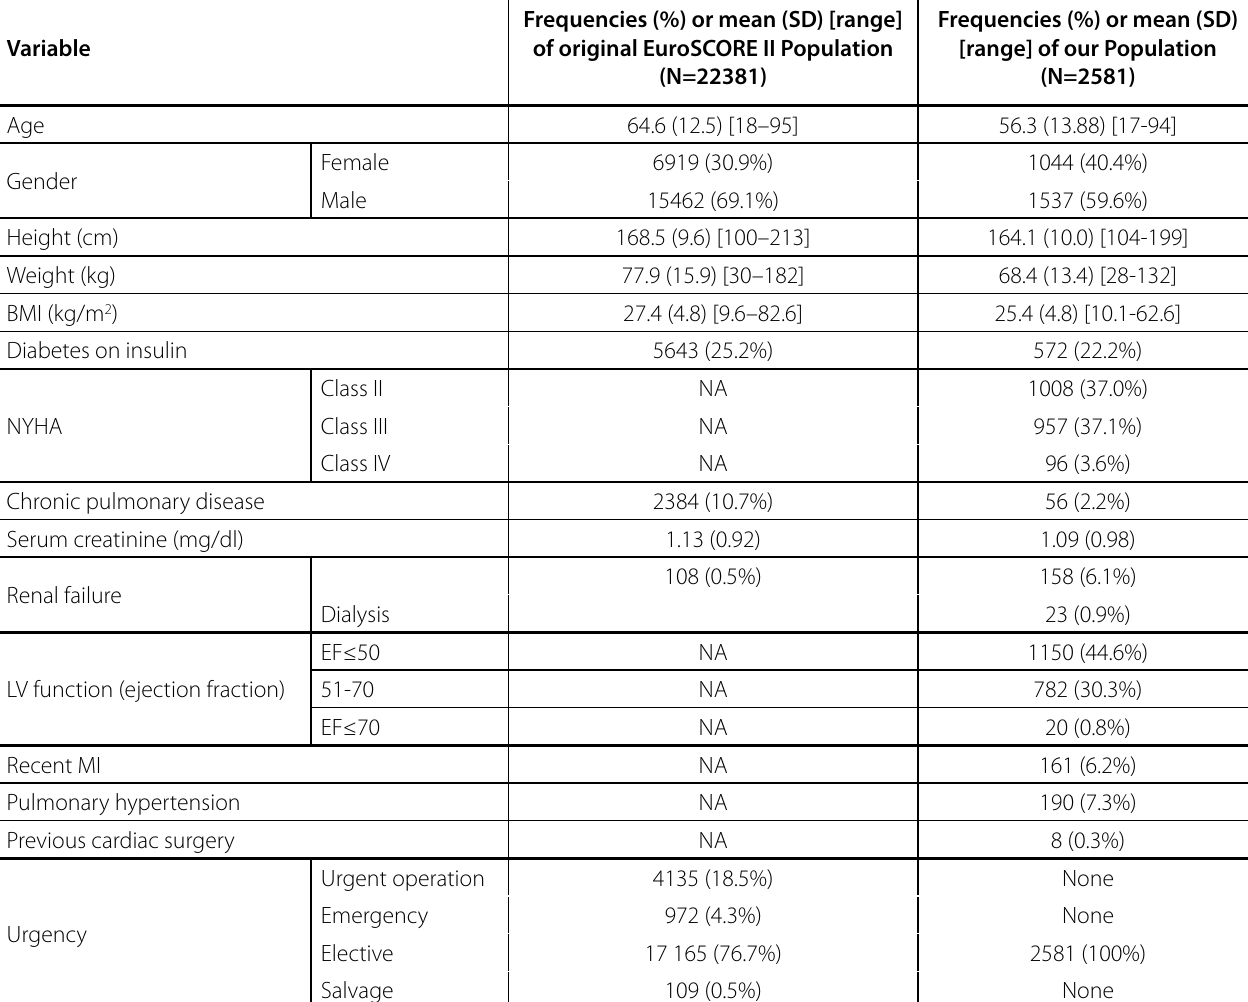
Table 1. Comparison of demographic and comorbidity characteristics between the original EuroSCORE II population and an Iranian sample [2]